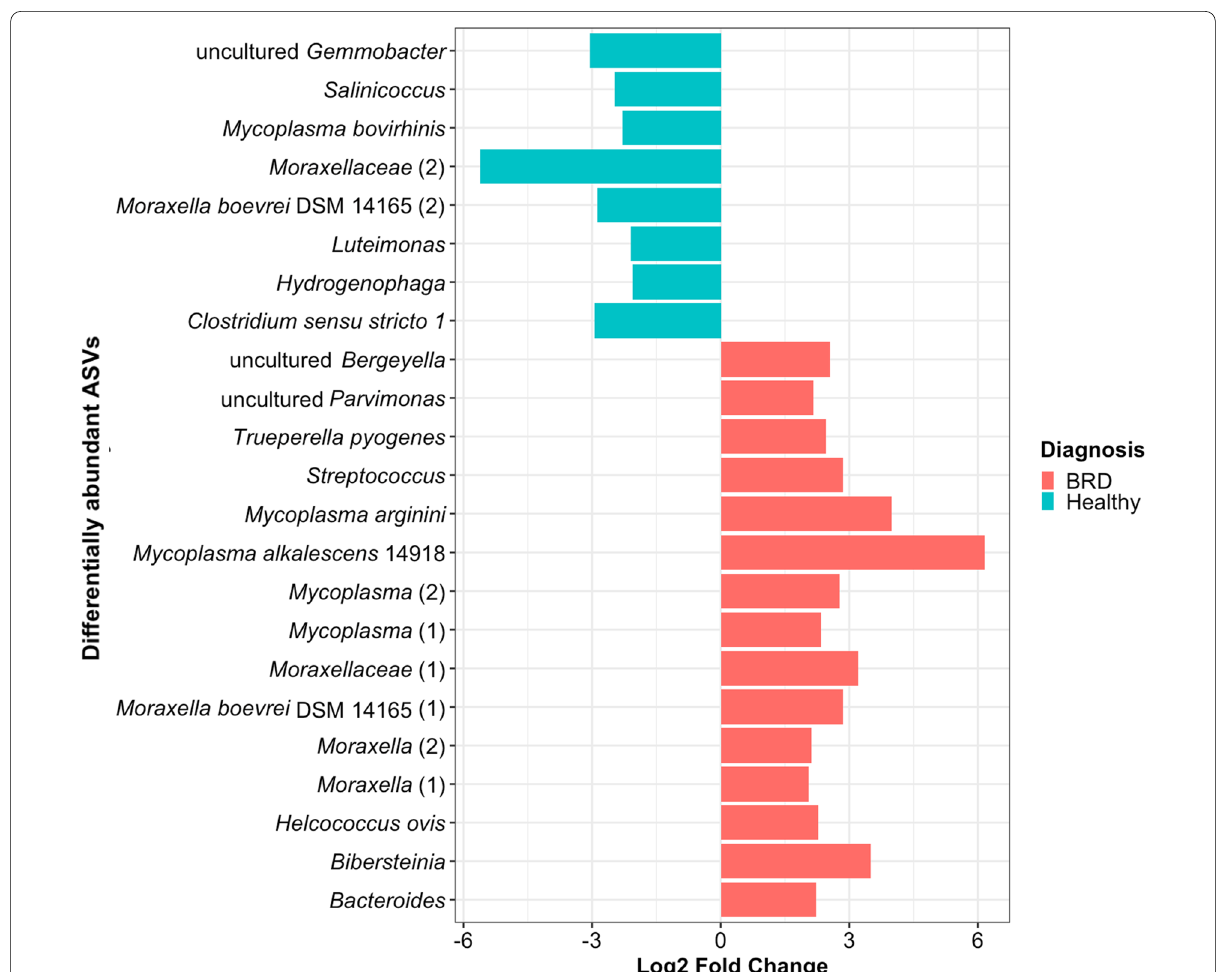
Fig. 3 Differentially abundant taxa (ASVs) between animals with BRD clinical signs (BRD) and healthy animals. Bar plot shows the taxa with a log 2 fold change greater than 2 or less than 2 and p 0.05. Those with a log 2 fold change > 2 were those enriched in BRD animals, while a log 2 fold − ≤ change < 2 were those decreased in the BRD animals. Taxa names contain numbers in parenthesis if multiple ASVs were assigned the same −